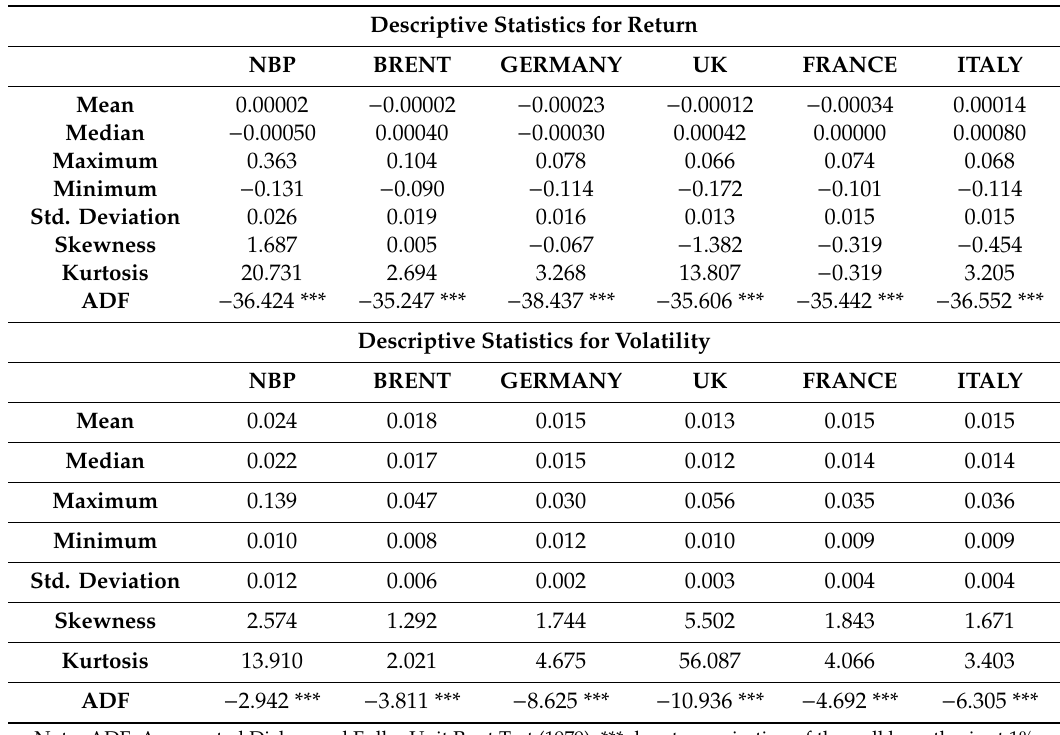
Table 3. Descriptive statistics for return and volatility in